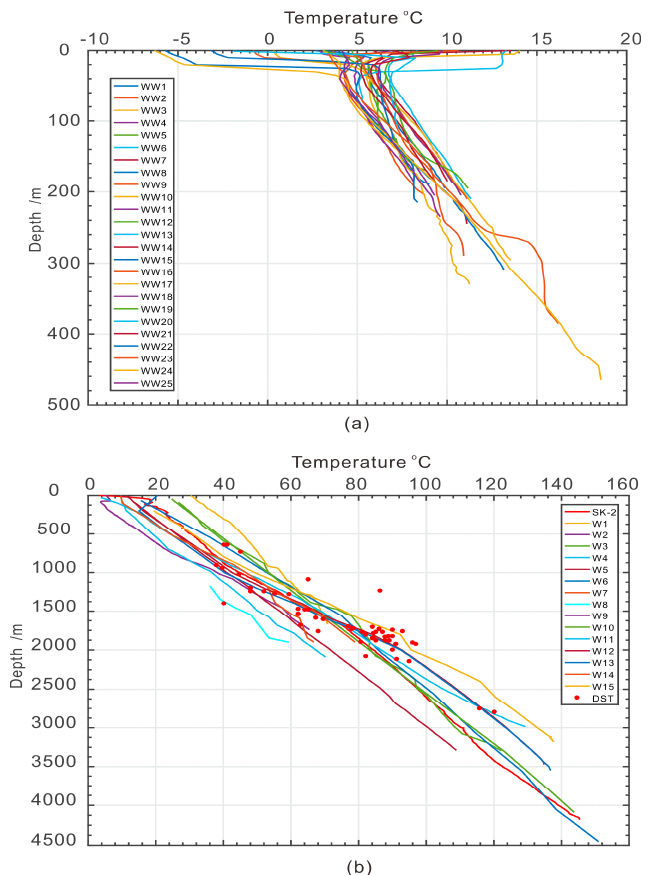
Figure 2. ( a ) Temperature logs from shallow water wells; ( b ) temperature logs from deep oil wells and geothermal wells, along with DST in the oil wells. Temperature logs of SK ‐ 2, W1, and W2